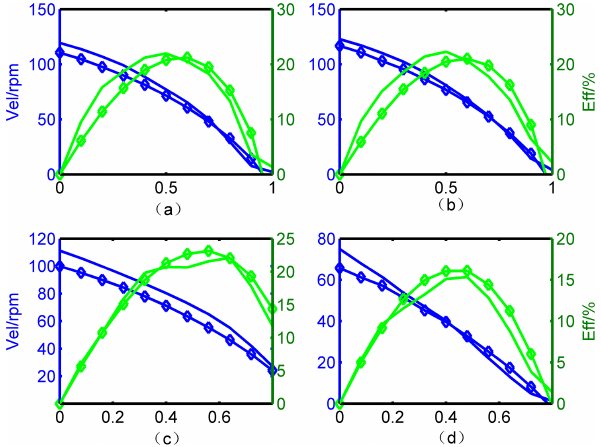
Figure 12. Comparison of the mechanical characteristics be- tween simulation and experimentation: (a) 0.9V, 41.5kHz; (b) 1V, 41.5kHz; (c) 1.3V, 42kHz; (d) 1.3V,